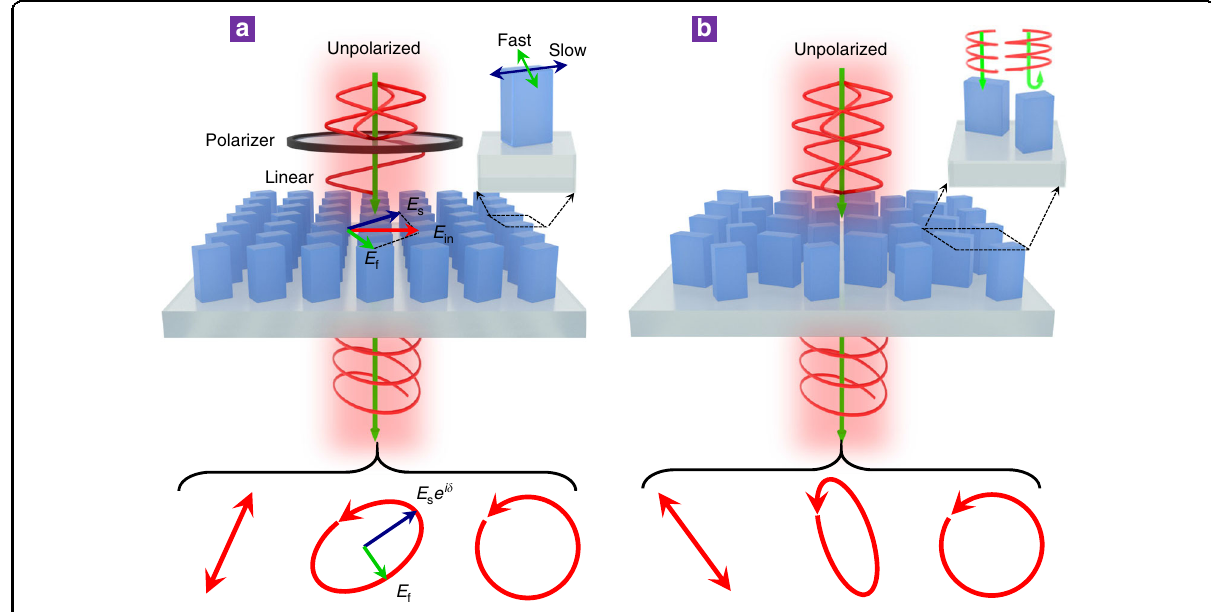
Fig. 1 Comparison of the polarization controls based on the birefringence and dichroism metasurfaces. a Schematic of conventional polarization control based on a cascaded linear polarizer and birefringent single-meta-atom metasurface. The incident beam with well-de fi ned polarization was converted to arbitrary polarization states by imparting different phase retardations on orthogonal linear polarizations along the fast and slow axes of the birefringent meta-atom. b Schematic of the proposed all-in-one polarizer that can function at an arbitrary position on the Poincaré sphere by design based on a dielectric metasurface composed of dimerized nanopillars, which can directly operate with unpolarized incident light and generate arbitrary polarization states, including linear, elliptical and circular polarizations, regardless of the incident polarization